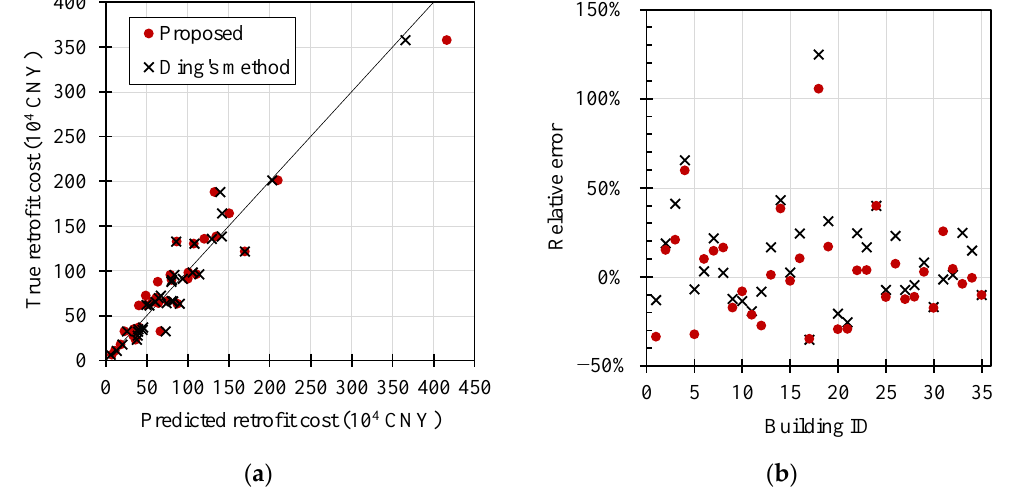
Figure 3. Comparison of different regression models. ( a ) Prediction results; ( b ) relative